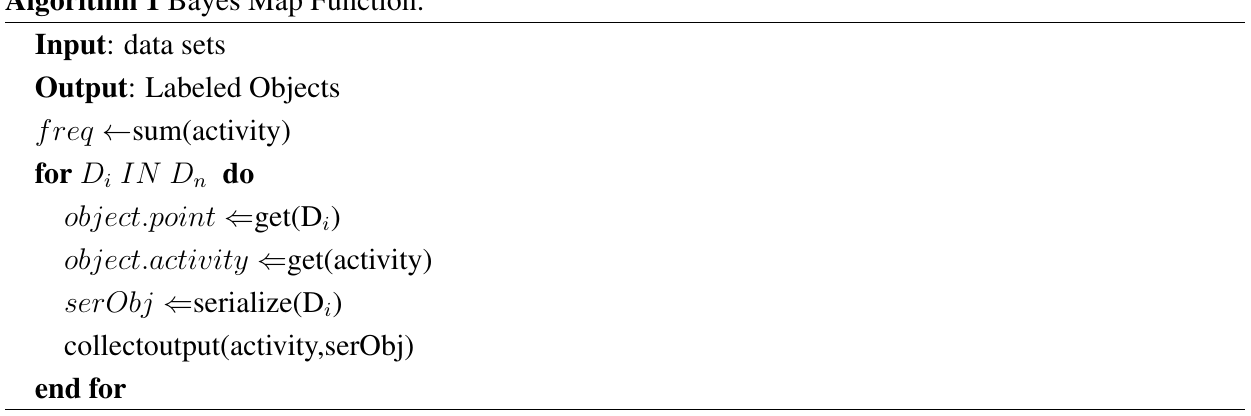
Algorithm 1 Bayes Map Function.